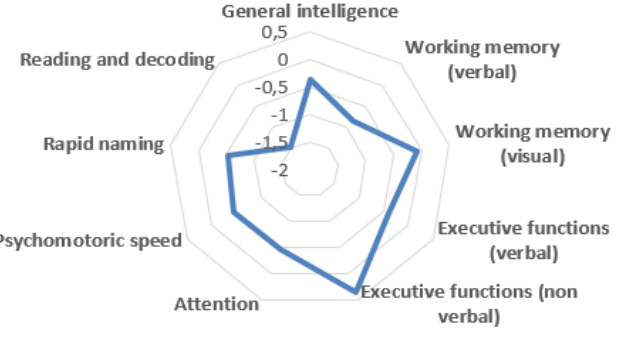
Figure 1. Results on cognitive